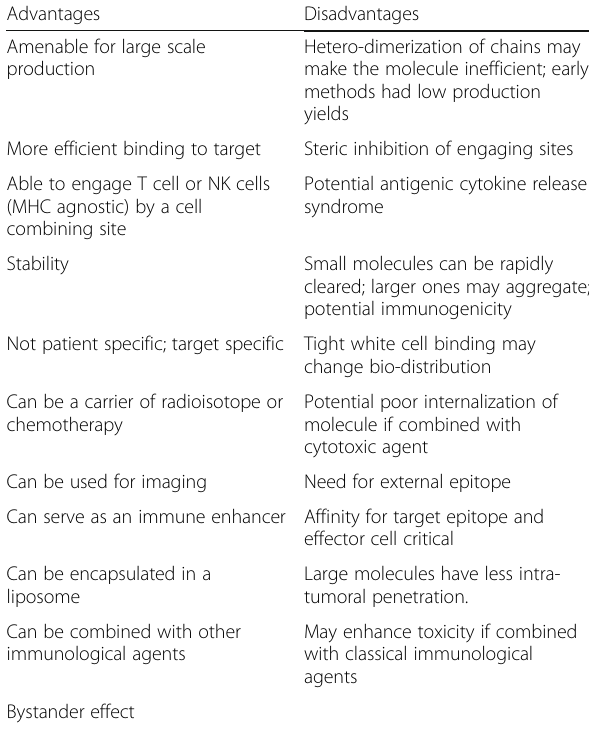
Table 1 Advantages and disadvantages of polyspecific antibodies over monospecific